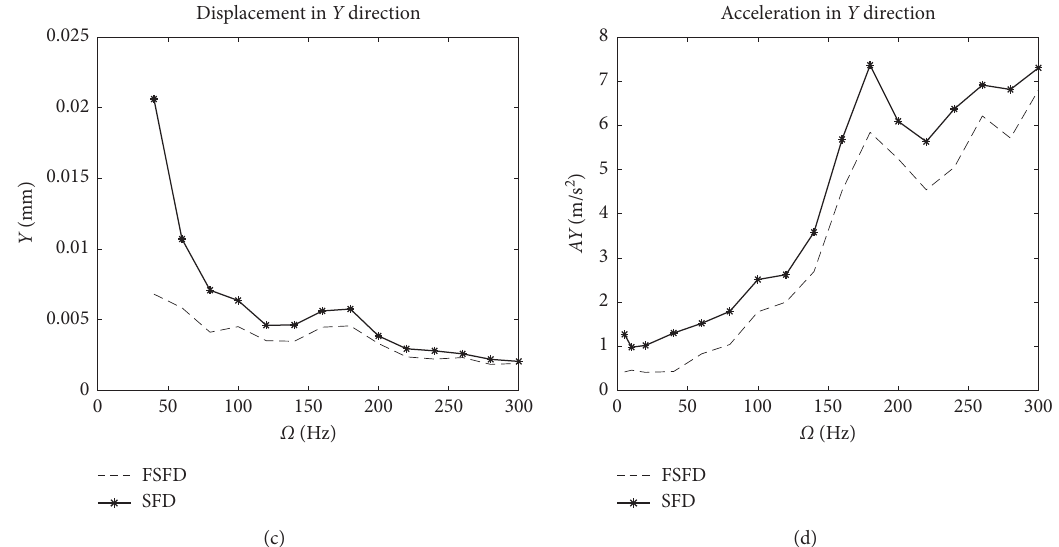
Figure 15: DCSFD vs. SFD for support 1: (a) X directional displacement; (b) X directional acceleration; (c) Y directional displacement; (d) Y directional acceleration.